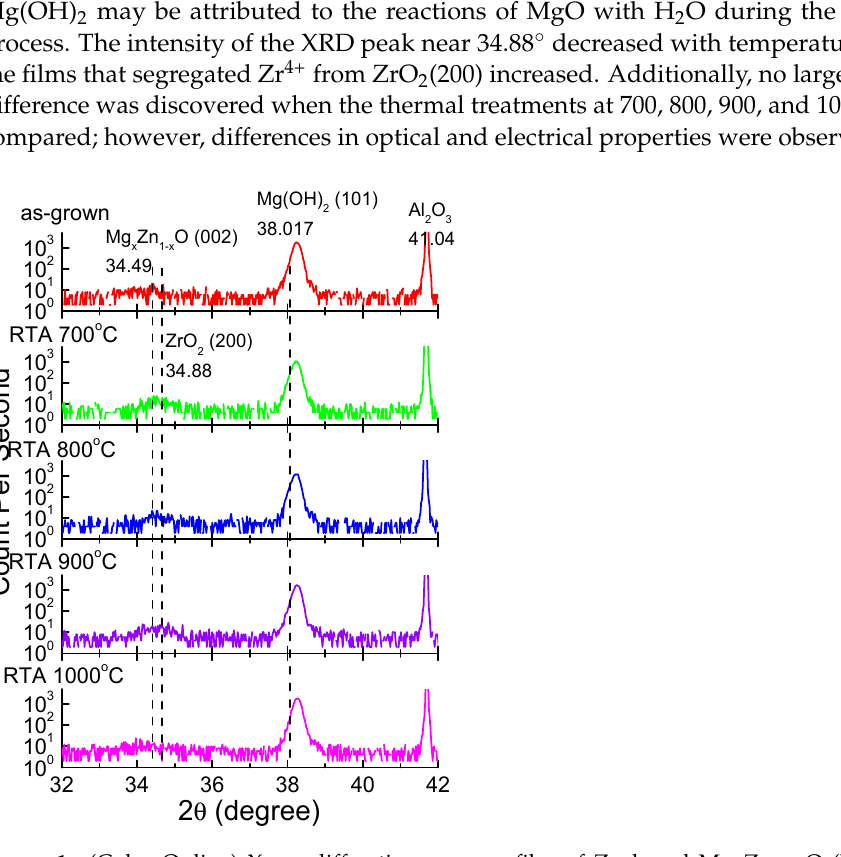
x Zn 1 − x O films.